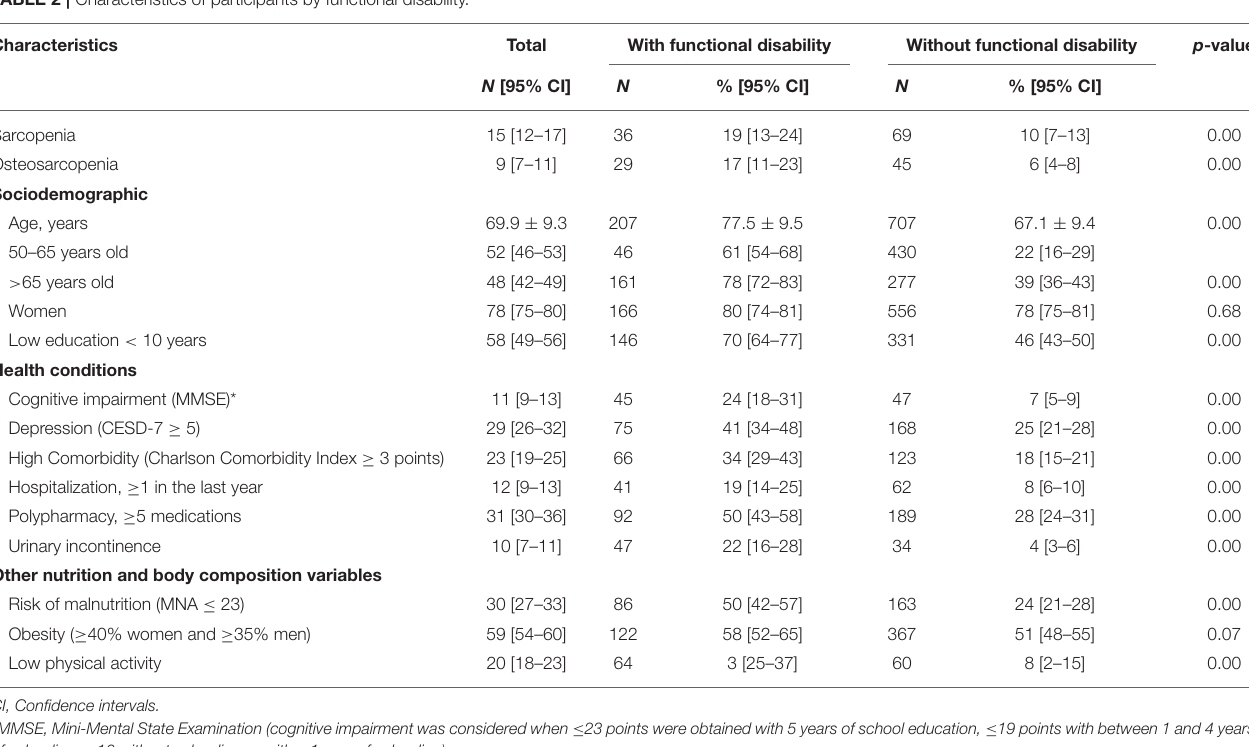
with SP only. This coincides with the results of other